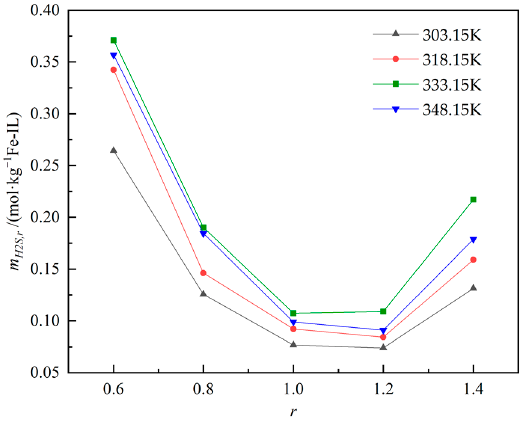
Figure 6. Influence of iron content on chemical solubility at different temperatures at 200 kPa.